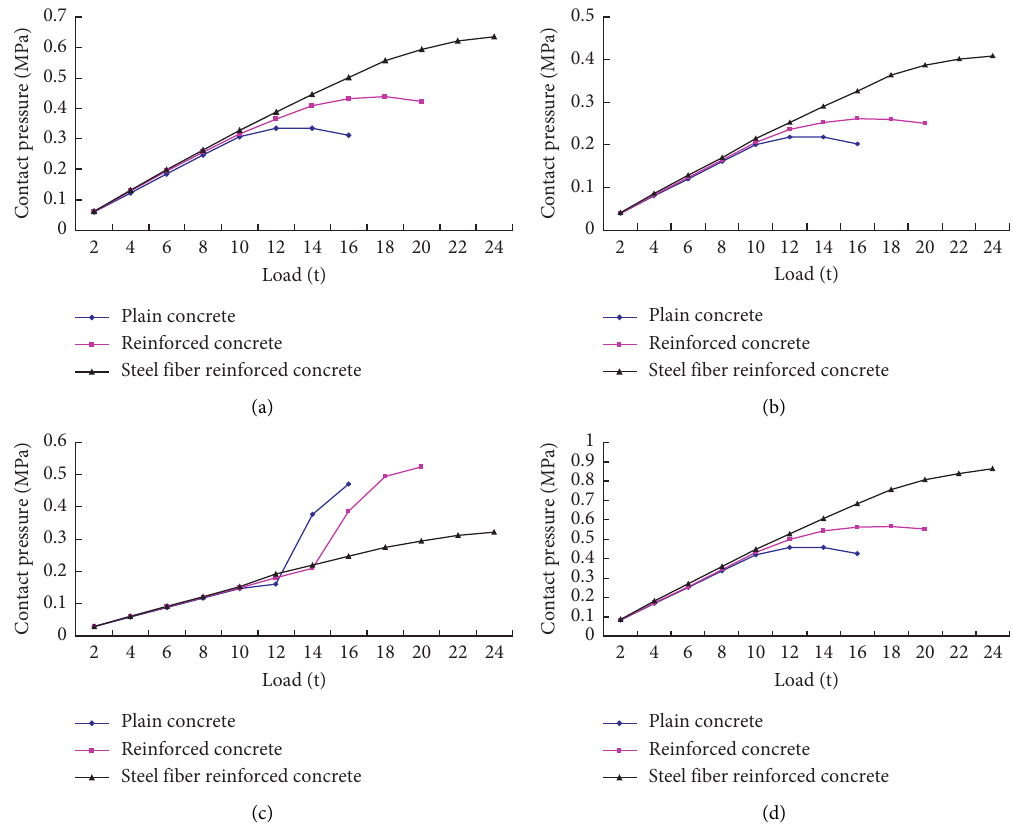
Figure 14: Change of contact pressure with a load. (a) Measuring point 1 (vault). (b) Measuring point 2 (haunch). (c) Measuring point 3 (middle of the side wall). (d) Measuring point 4 (middle of the inverted